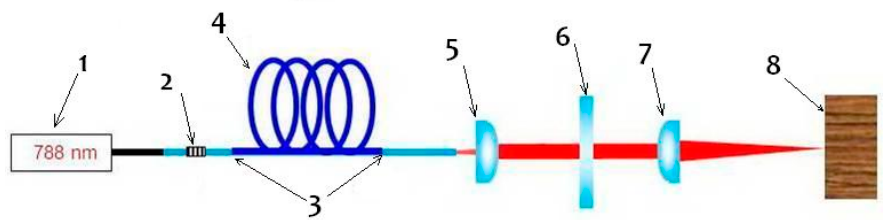
Figure 2. Diagram of the laser setup used in the preliminary study: (1) semiconductor pumping laser with a wavelength of 788 nm, (2) fiber Bragg grating, (3) fiber splice connection, (4) Tm-doped fiber, (5) collimator, (6) filter (HR 788 nm/AR 2 μ m), (7) converging lens, and (8) wooden workpiece.